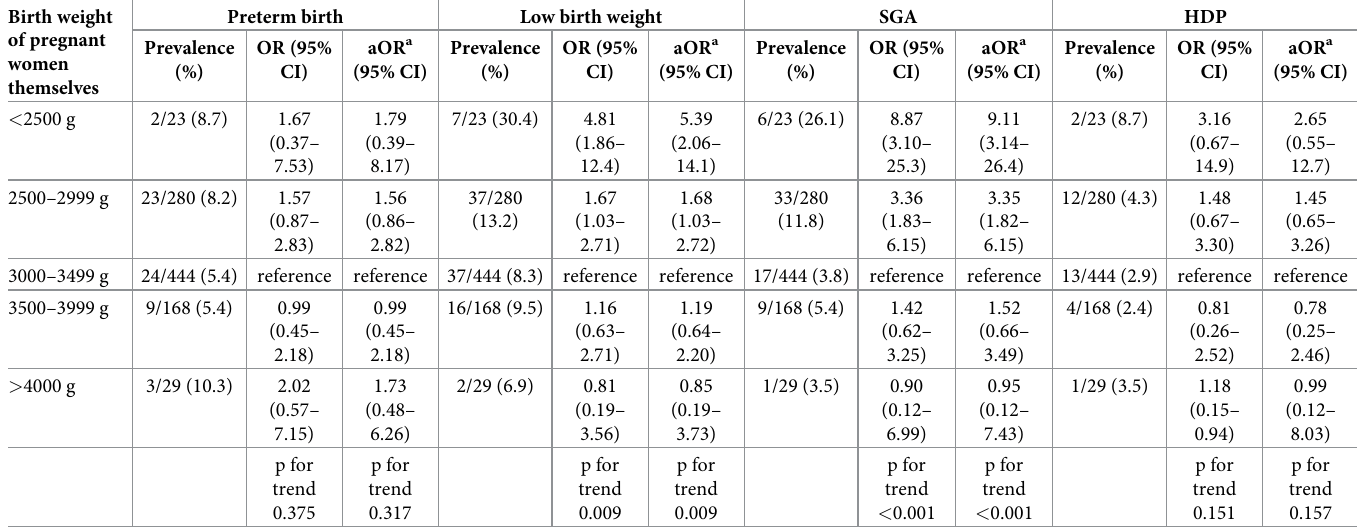
Table 2. Main analysis (N = 944) among women born at